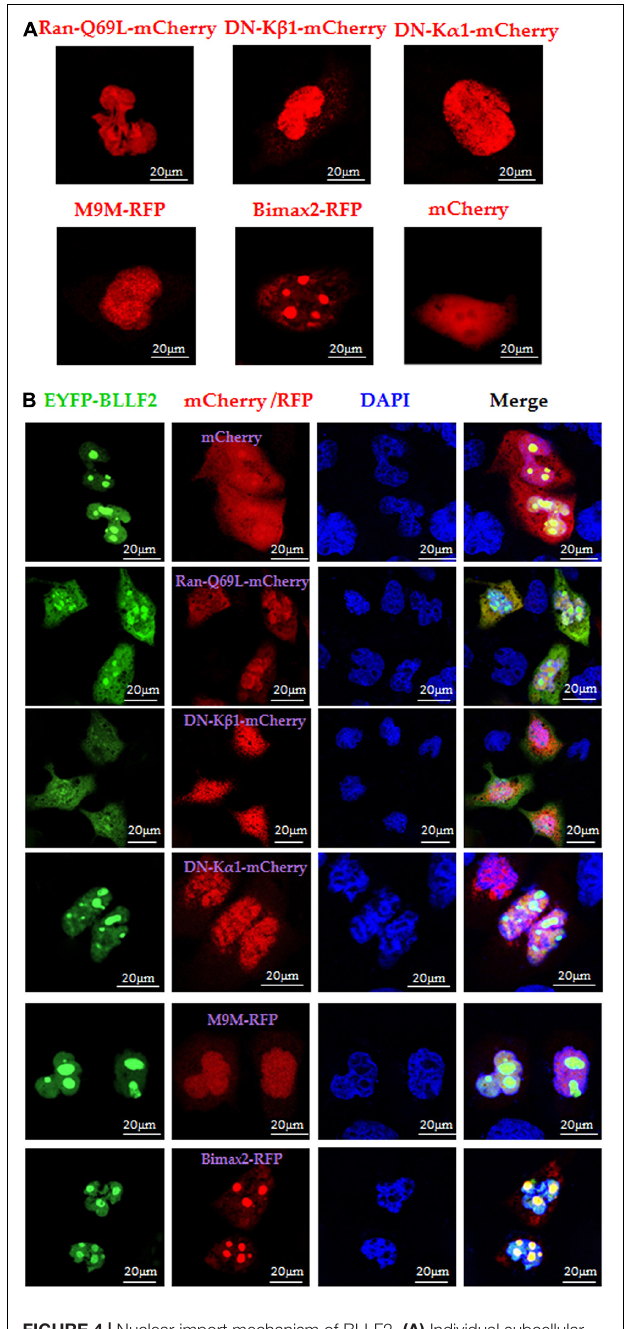
FIGURE 4 | Nuclear import mechanism of BLLF2. (A) Individual subcellular localization of Ran-Q69L-mCherry, DN k α 1-mCherry, DN k β 1-mCherry, M9M-RFP, Bimax2-RFP, or mCherry vector in COS-7 cells. (B) Co-expression of Ran-Q69L-mCherry/EYFP-BLLF2, DN k α 1-mCherry/EYFP-BLLF2, DN k β 1-mCherry/EYFP-BLLF2, M9M-RFP/EYFP-BLLF2, Bimax2-RFP/EYFP-BLLF2, or mCherry/EYFP-BLLF2 in COS-7 cells. All scale bars indicate 20 µ